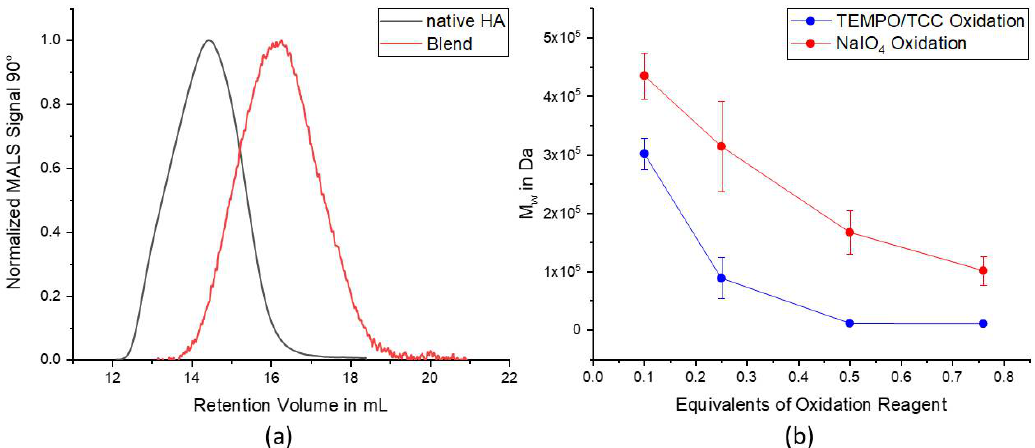
Figure 2. Determination of the molecular weights of the obtained oxidized HA: ( a ) Representative GPC elugrams of the blend as compared with the native HA; ( b ) weight average molecular weight (M w ) in kDa for the differently oxidized